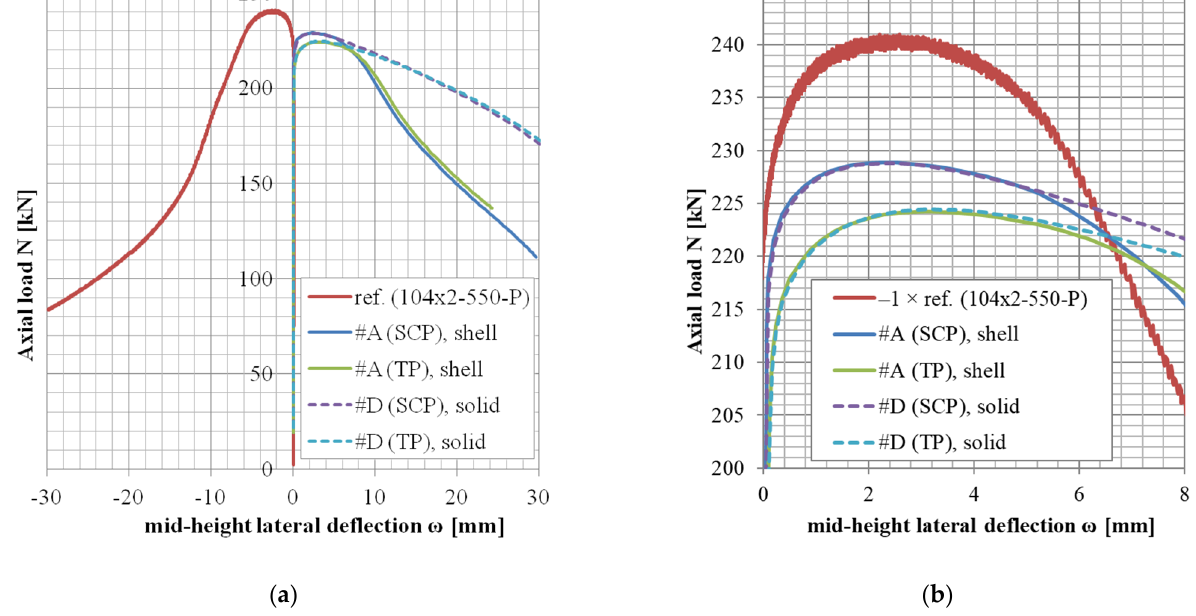
Figure 9. Experimental and FE load vs. midheight lateral deflection curves of 104 × 2-400-P [38]: ( a ) whole*; ( b ) zoomed.